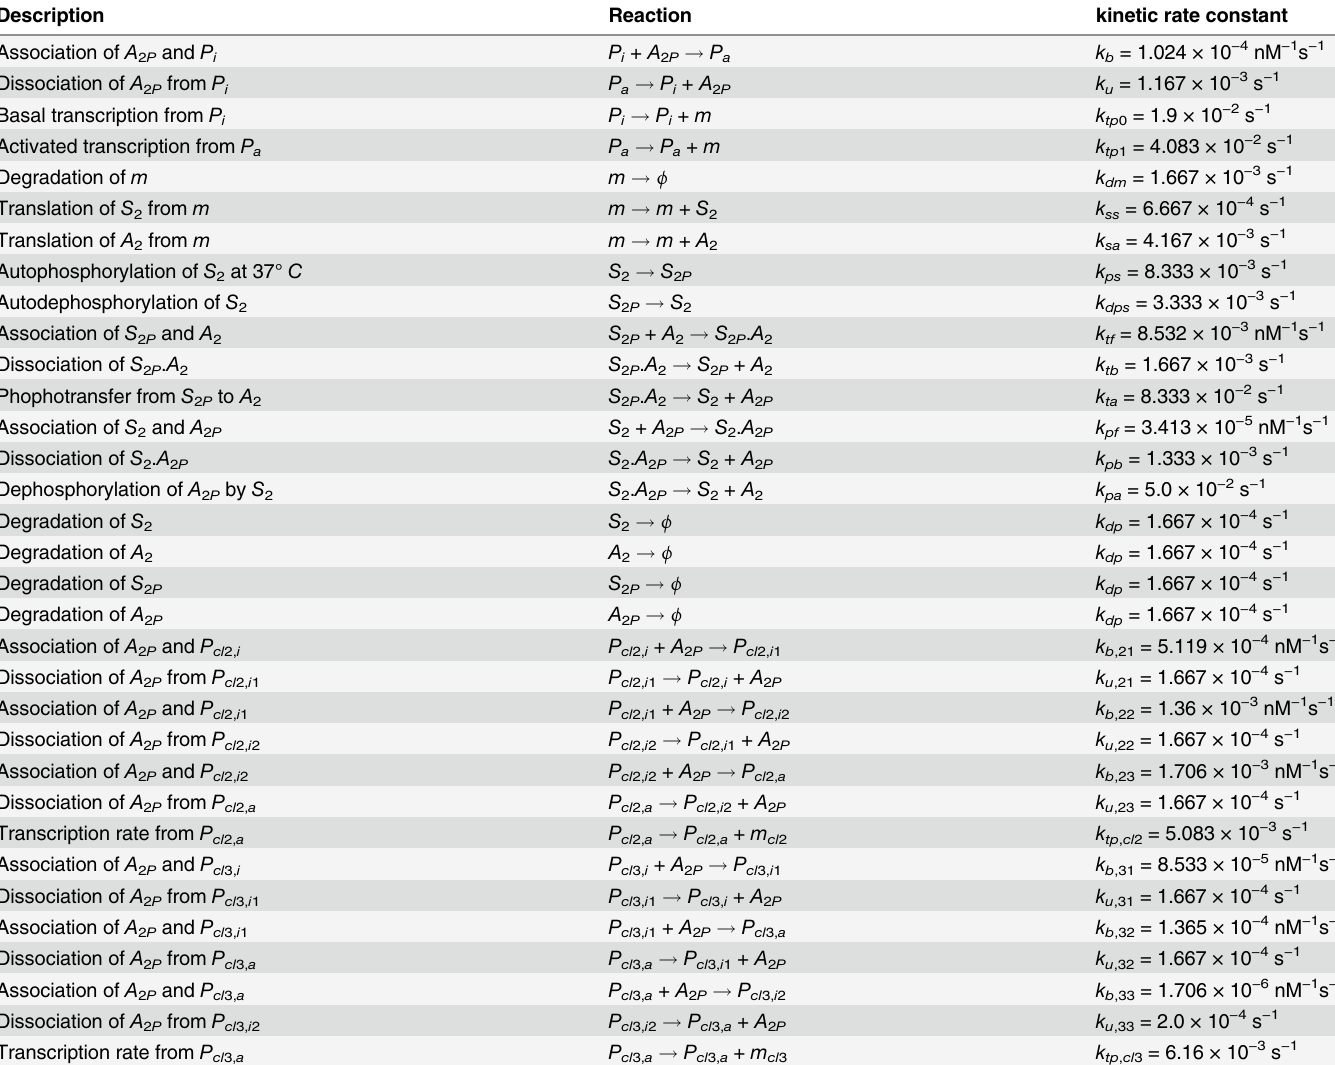
Table 1. List of kinetics schemes and the values of rate parameters used in the